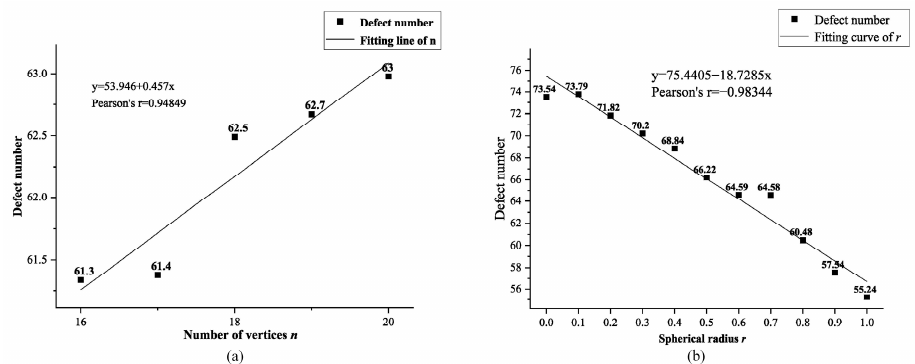
Figure 11. Linearly related random variables: ( a ) number of vertices; ( b ) spherical